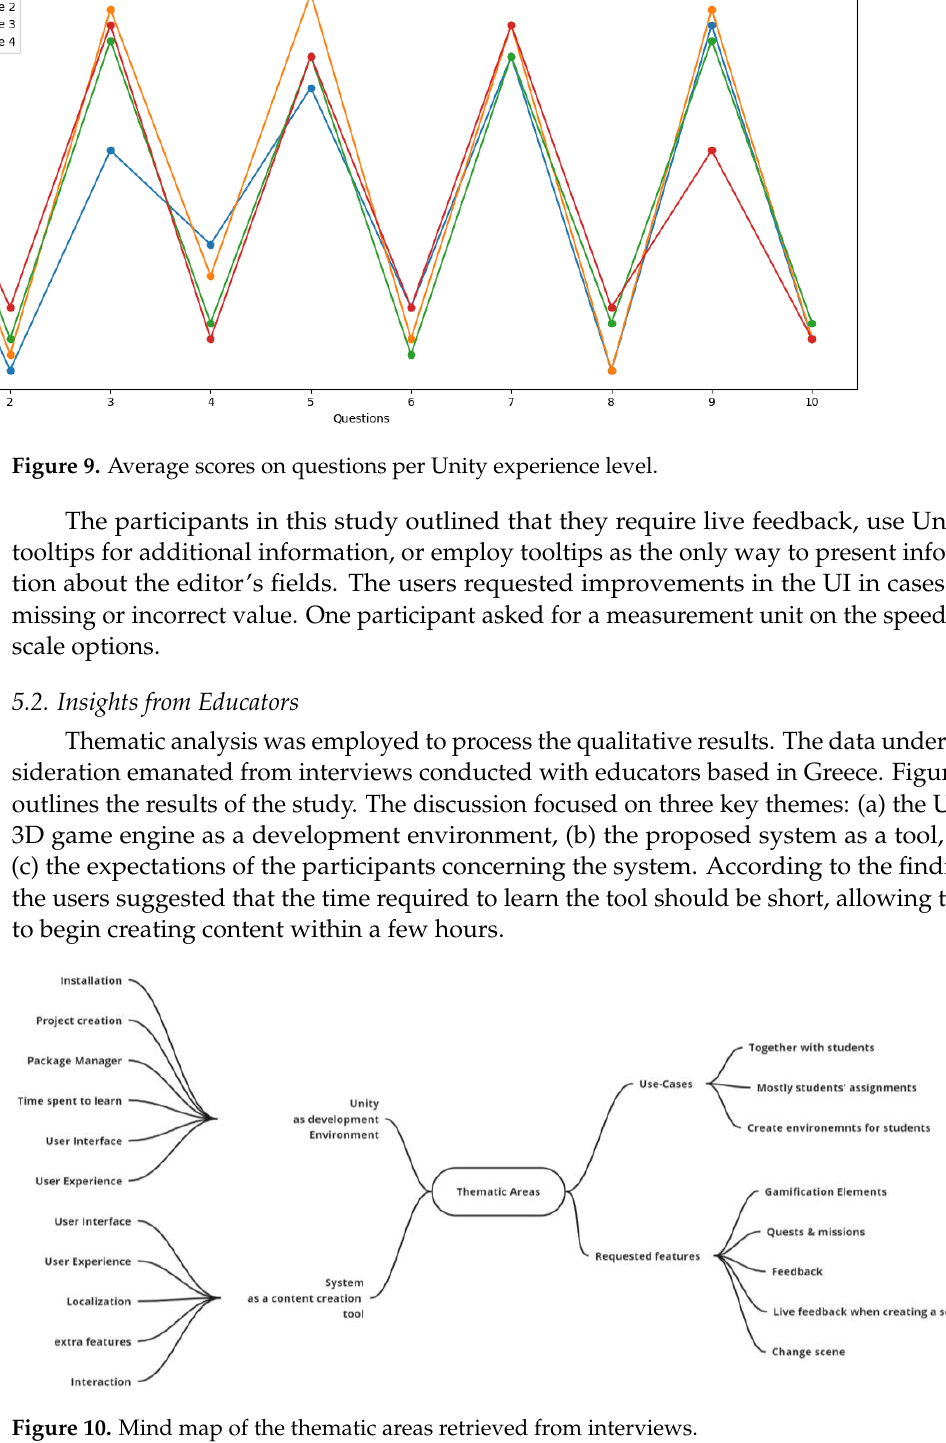
Figure 10. Mind map of the thematic areas retrieved from interviews.